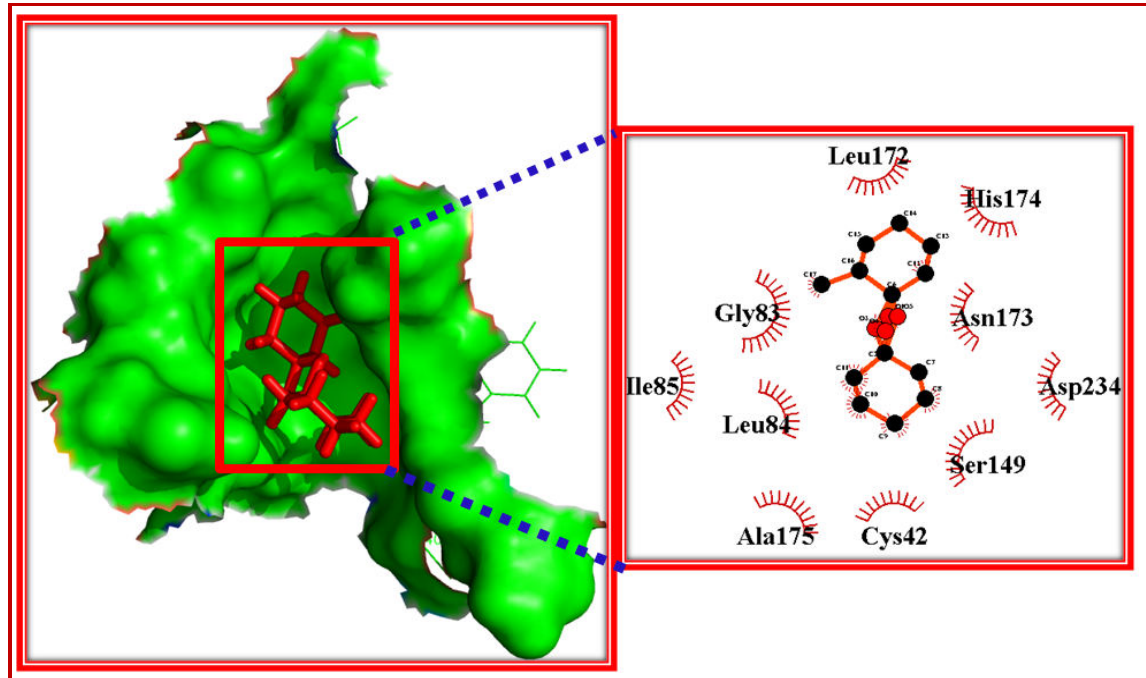
Figure 1: Docked complex of compound 5c in the binding pocket of